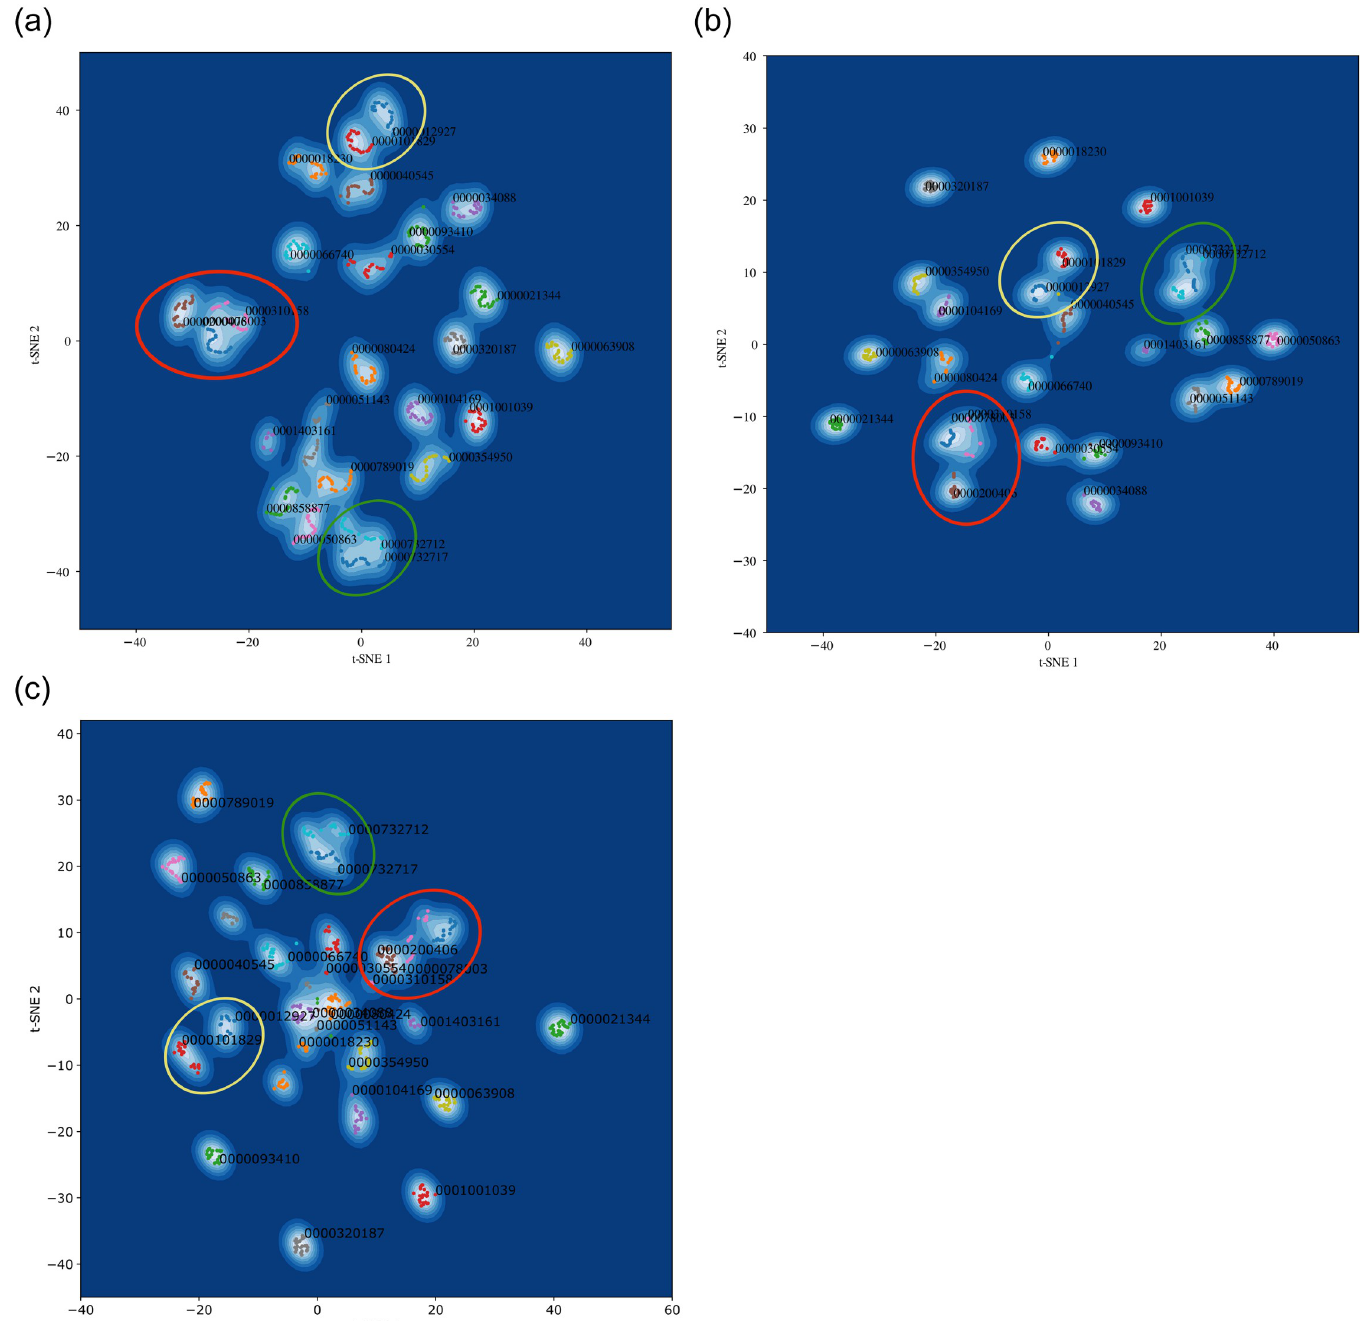
Fig 9. t-SNE of documents describing the products of twenty-five firms from the Dow Jones Industrial Average, embedded in the product spaces from models Boolean (left), TF-IDF (middle), and PV-DM (right). Points indicate the location of a given document, colored by firm; document clusters are labeled by dominant CIK. Firms that produce pharmaceuticals are circled in red, aerospace companies are circled in yellow and telecommunication companies are circled in green.